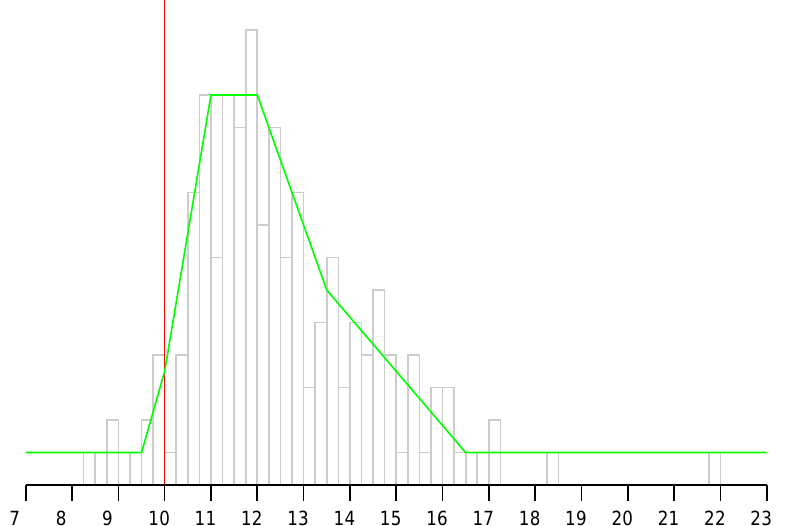
Figure 10. A slice through a particular observation model. Horizontal axis: measured distance (when actual distance is 10 m) Grey histogram: measurements from typical three-level residence. Green curve: observation model—probabilty of measuring the specified distance (piece-wise linear fit to grey